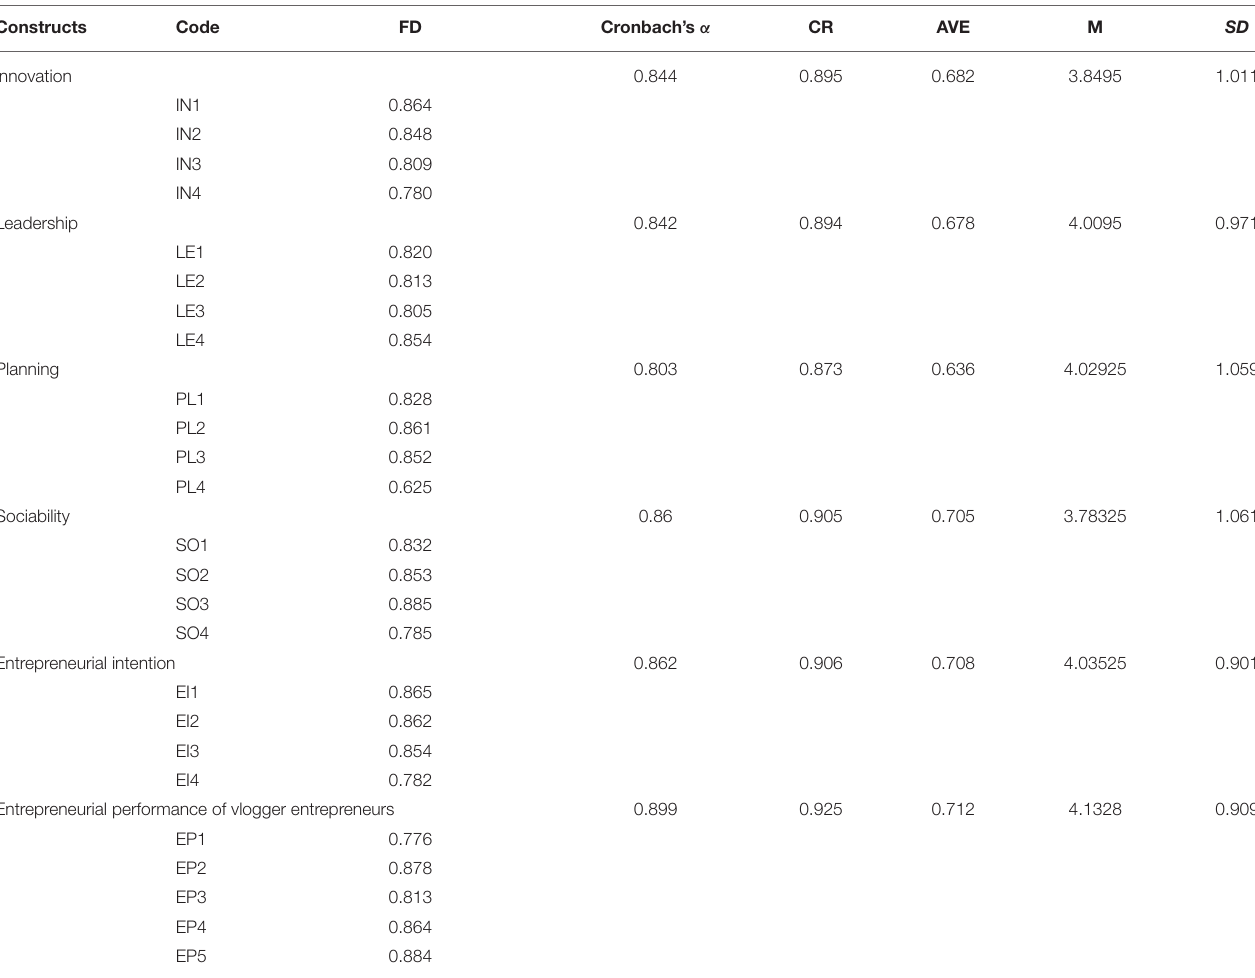
TABLE 2 | Measurement model and descriptive